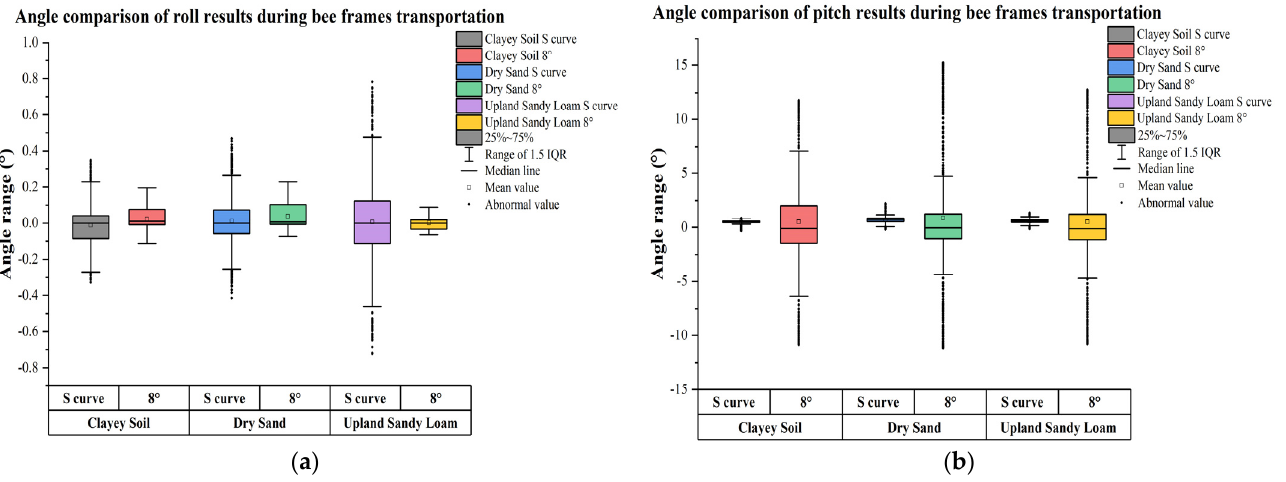
Figure 21. Box plot of ( a ) variation in roll values under each pavement condition when the loading box is fully loaded with bee frames and ( b ) variation in pitch values under each pavement condition when the loading box is fully loaded with bee